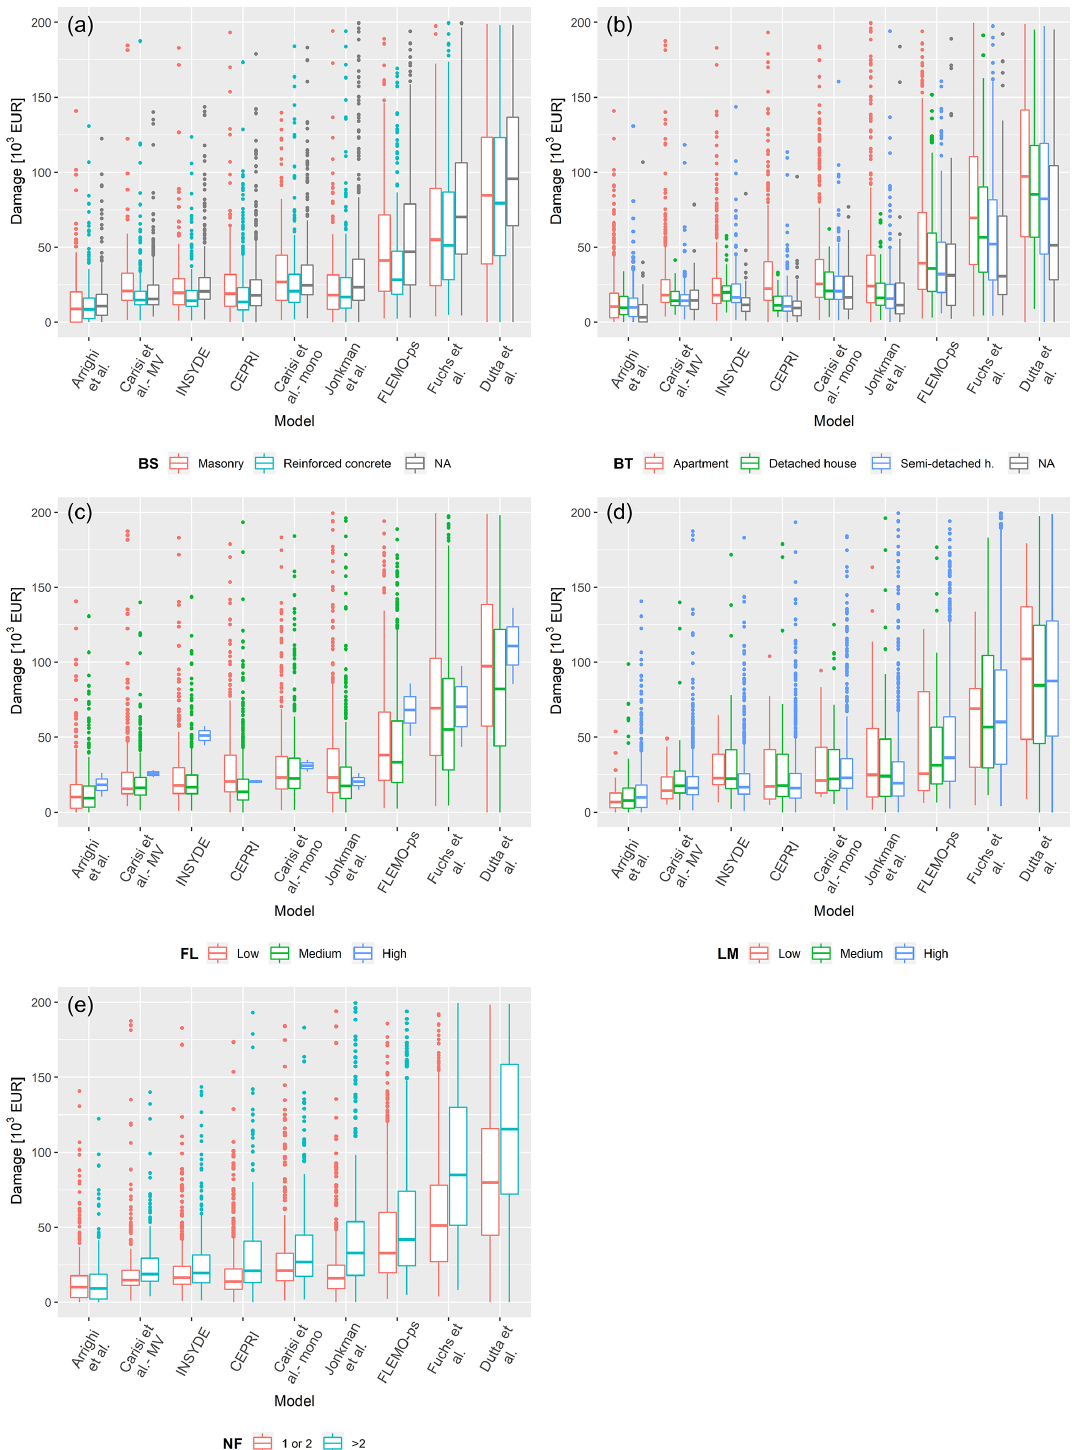
Figure 7. Box plots of damage estimates obtained with the tested models for different classes of building structure – BS (a) , building type – BT (b) , finishing level – FL (c) , level of maintenance – LM (d) , and number of floors – NF (e) . Models are organized according to increasing value of total damage